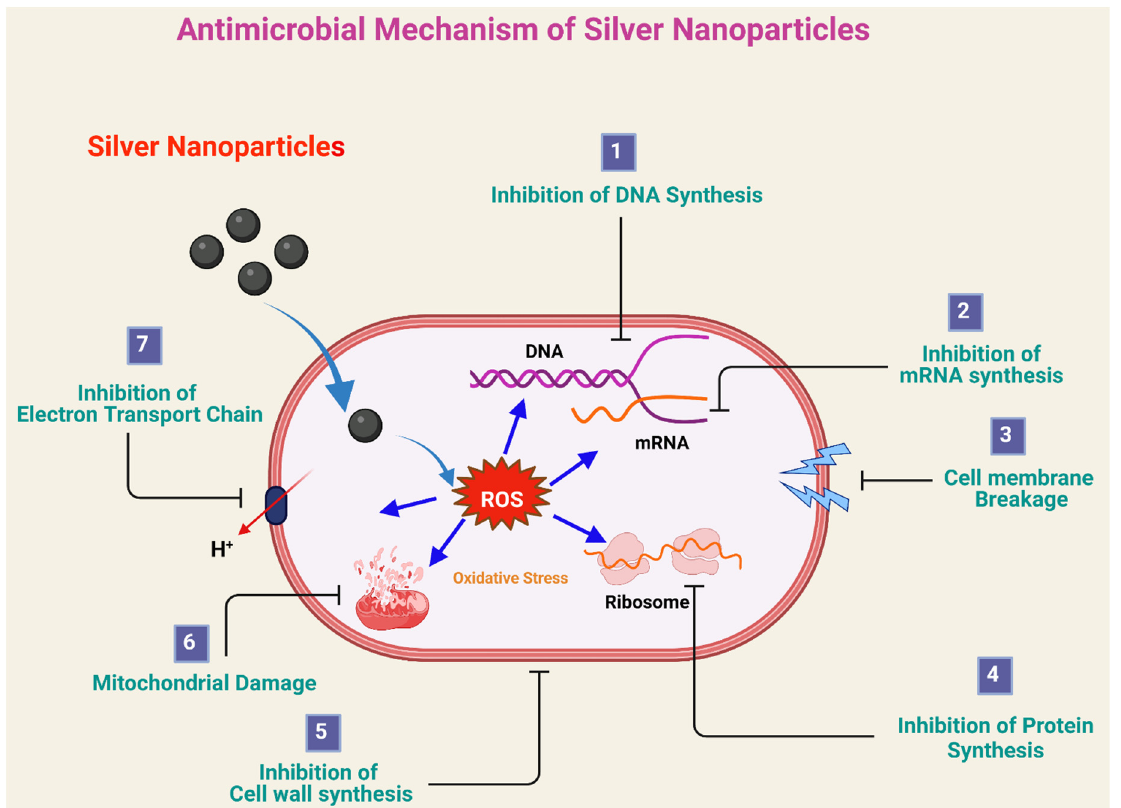
Figure 1. Antimicrobial mechanism of silver nanoparticles: (1) inhibition of DNA synthesis, (2) inhibition of mRNA synthesis, (3) cell membrane destruction and the leakage of the cell constituents, (4) inhibition of protein synthesis, (5) inhibition of cell-wall synthesis, (6) mitochondrial damage, and (7) inhibition of electron transport chain.